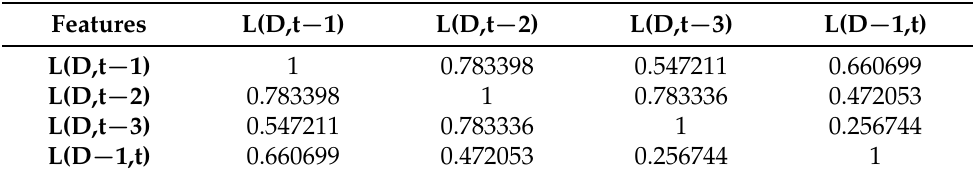
Figure 17. MLR: comparison of actual load and predicted load with trained MLR model. Table 5. MLR: coefficients and intercept information.